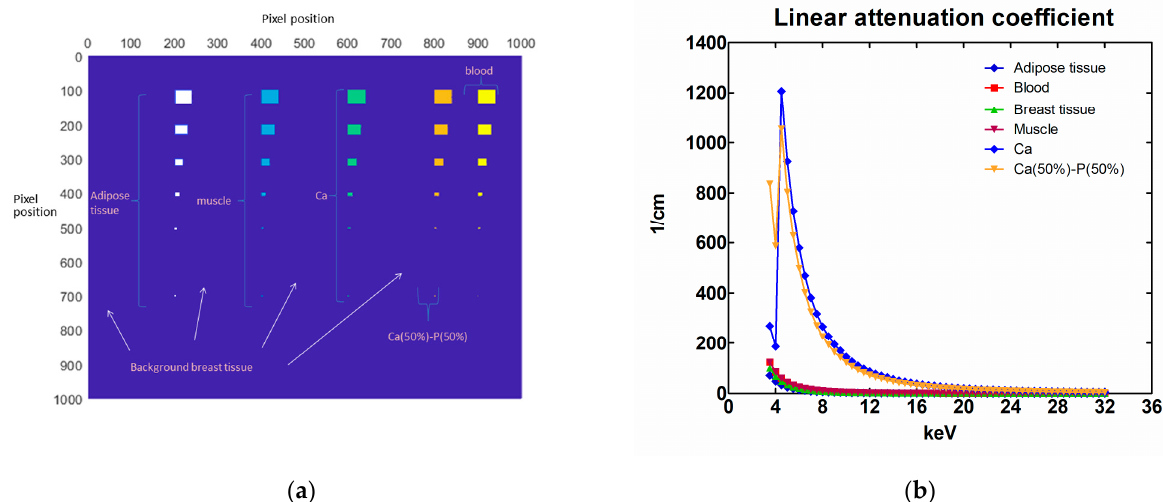
Figure 1. ( a ) The location of different lesion types on the mathematical phantom [30], and ( b ) the linear X-ray attenuation coefficients of the lesions. (Reference 30 is licensed under CC BY-NC-SA 4.0)